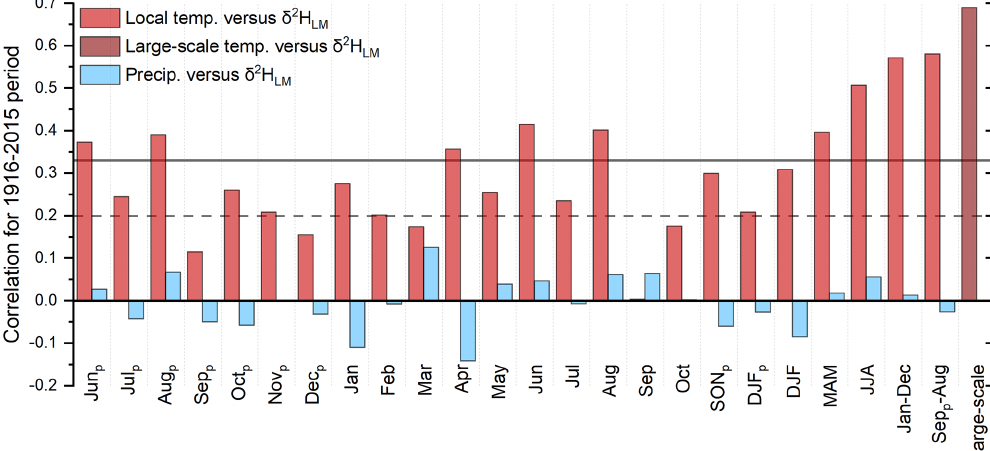
Figure 9. Correlation coefficients between the δ 2 H LM chronology, local and large-scale temperatures, and local precipitation amounts from 1916–2015. The subscript p indicates the months of the previous year, and the horizontal lines indicate the significance levels, with solid lines representing highly significant ( p < 0 . 001) and dashed lines representing significant values ( p < 0 . 05).